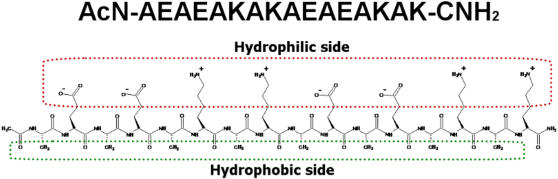
Schematic diagram of EAK16-II structure.The red portion shows the hydrophilic side of the peptide and the green portion shows the hydrophobic side of the peptide.